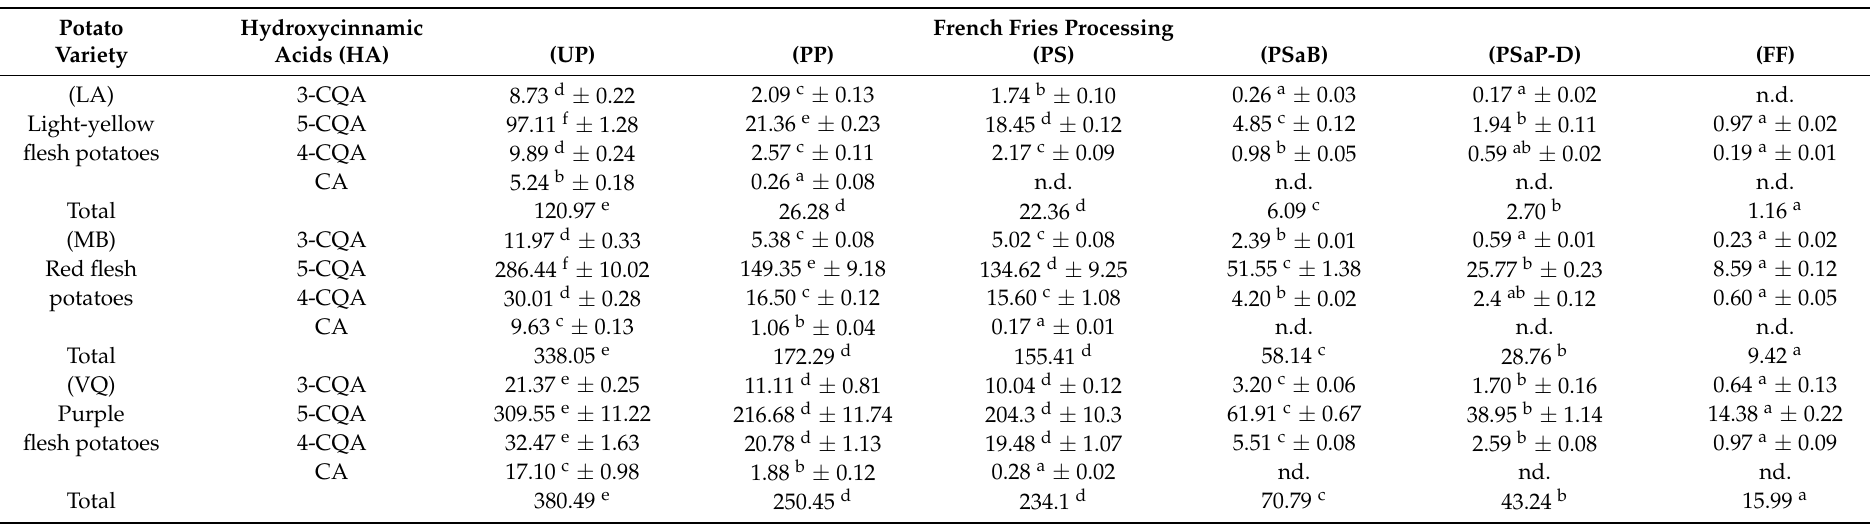
Table 1. The hydroxycinnamic acids content (mg · 100 g − 1 d.w.) in potato tubers of varieties with different coloured-flesh during the processing of French